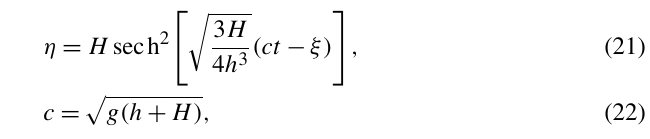
Figure 3. Schematic diagram of Tank 1. tan θ 1 = 25 / 17, tan θ 2 = 1 / 15 and tan θ 3 = 1 /